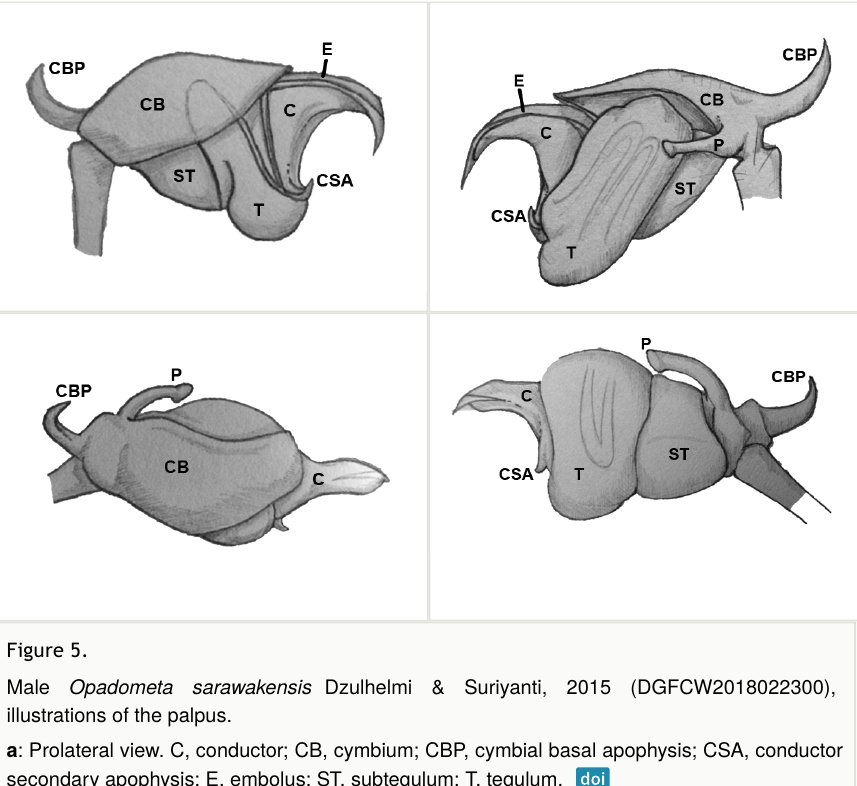
Figure 5. Male Opadometa sarawakensis Dzulhelmi & Suriyanti, 2015 (DGFCW2018022300), illustrations of the